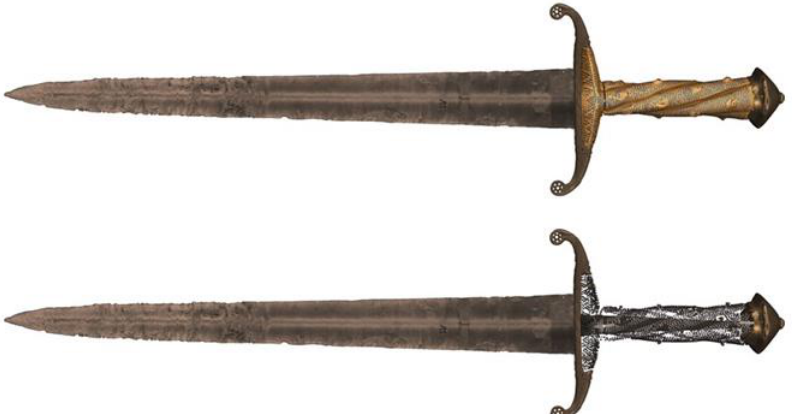
Figure 7. View of combined X-ray and neutron tomography dataset of the sword, comprising the complete structure of the object ( top ); with the wooden part withdrawn ( bottom ).